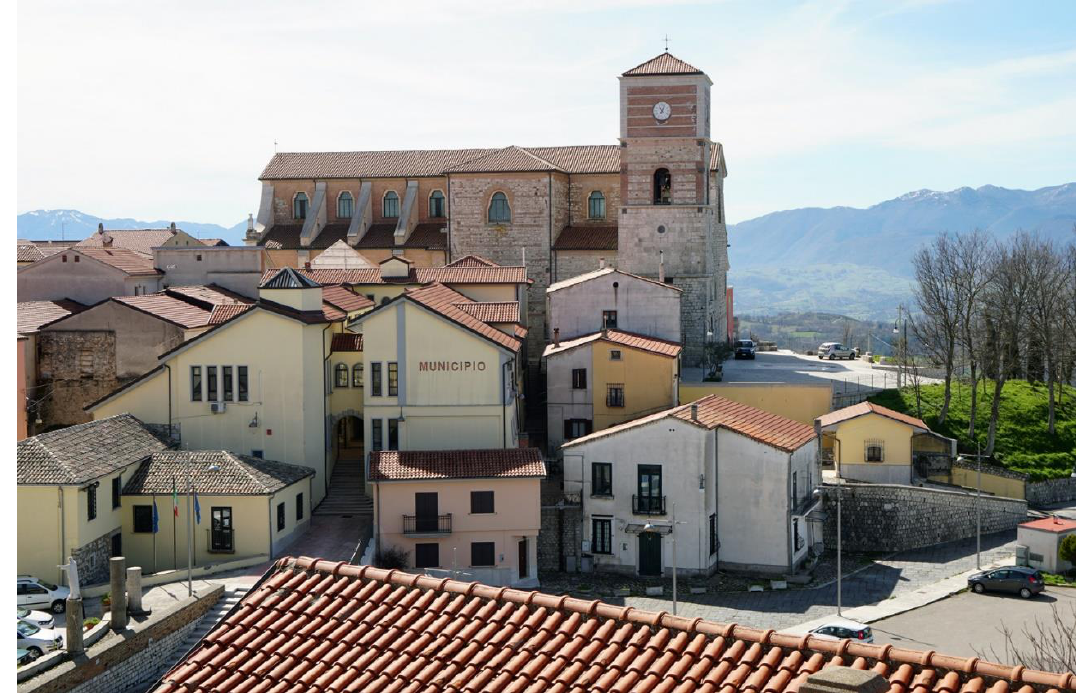
Figure 35. Sant’Angelo dei Lombardi: the historical center with the Town Hall, reconstructed taking into account the original urban design (photos by [35,36]).